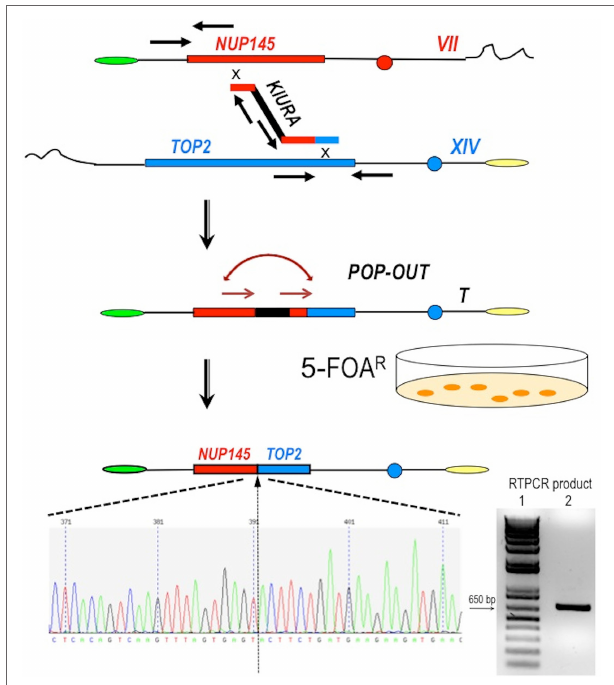
FigUre 2 | Scheme of the procedure to obtain a perfect fusion between NUP145 and TOP2 . The first step is represented by the bridge-induced translocation between NUP145 (Chromosome VII, shown in red) and TOP2 (Chromosome XIV, shown in blue) triggered by a BIT cassette. The URA3 gene from Kluyveromyces lactis (KlURA) was used as selection marker between the two homologous ends. Its POP-OUT, indicated by sequential arrows, was verified by selection on 5-FOA plates. The original chromatogram of one clone showing the perfect fusion between the two genes and the relative amplified chimeric transcript from one translocant (T) are also reported. Since the primers used in the RTPCR (sequence in Table S1 in Supplementary Material) are 418 and 241 bp far from the junction point, respectively, the size of the amplicon shown here is exactly 659 bp (lane 2 of the gel); lane 1:1 kb Plus ladder